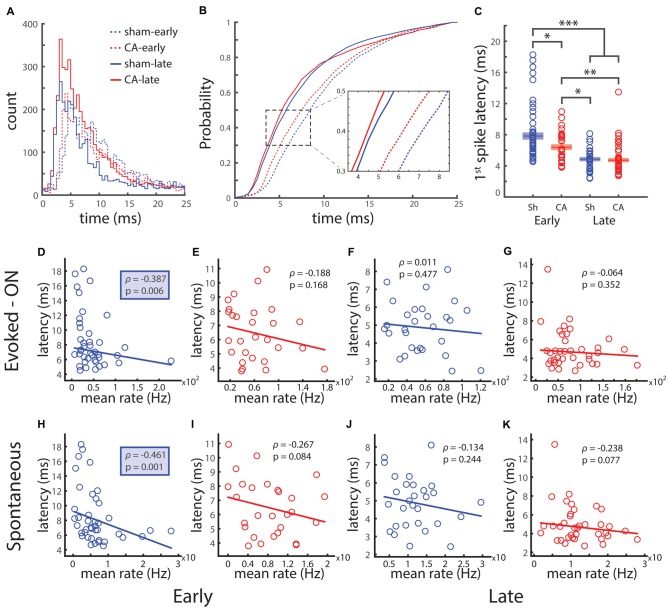
Spike timing of whisker-evoked responses depends on development and is affected by ischemic injury. (A) PSTHs for the 25 ms whisker deflection ON period. (B) The cumulative distribution of spike times during the 25 ms ON period. Zoom: the population average time to 40% of spikes shows that the same proportion of spikes occurs earlier for late groups compared to early groups and for CA-early compared to sham-early. (C) The latency between whisker deflection onset and the first spike in trials with non-zero response is significantly longer for sham-early vs. all other groups, and CA-early vs. late groups. (D) The first spike latency and evoked spike count is negatively correlated for the early sham group. (E–G) First spike latency and evoked count are uncorrelated for CA-early and both late groups. (H) First spike latency and spontaneous spike count are negatively correlated for sham-early rats. (I–K) First spike latency and spontaneous spike count are not significantly correlated for early CA and both late groups. *Indicates p < 0.05, **indicates p < 0.01 and ***indicates p < 0.001.